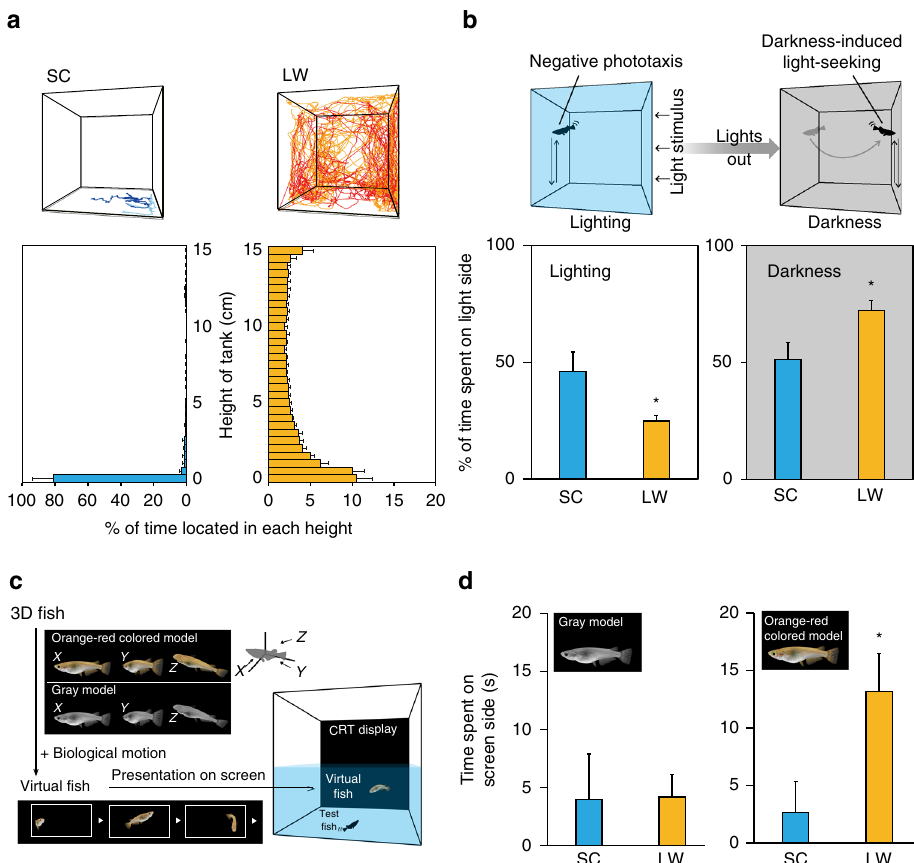
Fig. 1 Medaka undergo seasonal changes in behavior. a Top : Behavioral traces of two individuals under long day/warm temperature (LW) and short day/ cool temperature (SC) conditions. Different colors denote traces for each individual. Bottom : Time spent at each height of the tank. b Top : Medaka (LW fi sh) exhibited negative phototaxis ( left ) and darkness-induced light-seeking behavior ( right ). Bottom : ( left ) LW fi sh exhibited negative phototaxis to a white light stimulus, whereas SC fi sh swam randomly (* P < 0.05, t -test; mean + SEM, n = 5 – 9). ( right ) When the light was turned off, LW fi sh immediately moved to the opposite side of the tank, whereas SC fi sh failed to exhibit this darkness-induced light-seeking behavior (* P < 0.05, t -test; mean + SEM, n = 5 – 9). c Three-dimensional computer graphics (3D-CG) medaka (see Supplementary Movie 1). d ( left ) When presented with a gray model fi sh on the screen, neither SC nor LW test fi sh showed a preference ( P > 0.05, t -test; mean + SEM, n = 8 – 10). ( right ) By contrast, LW test fi sh spent more time on the screen side when presented with orange-red-colored model fi sh, whereas SC fi sh did not show a preference (* P < 0.05, t -test; mean + SEM, n =